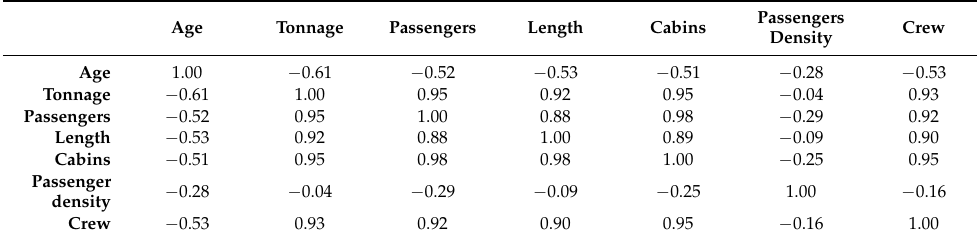
Table 11. Correlation matrix for cruise-ship-info data.